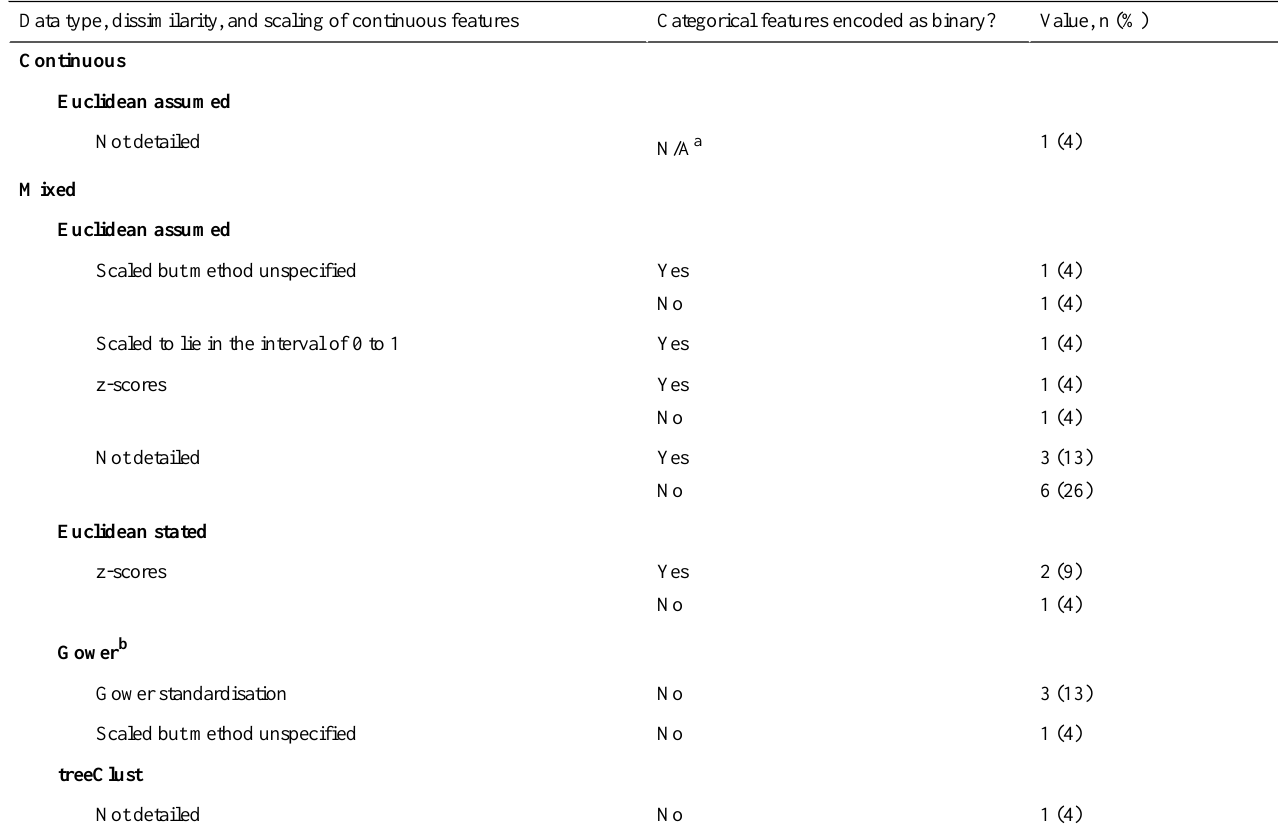
Table 2. Breakdown of methods used by studies applying hierarchical clustering with Ward's linkage